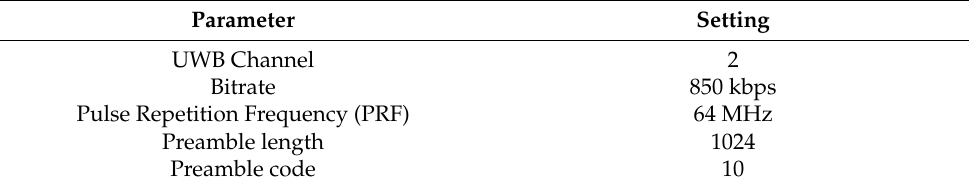
Table 3. Settings used in the on-body positioning experiment. Parameter